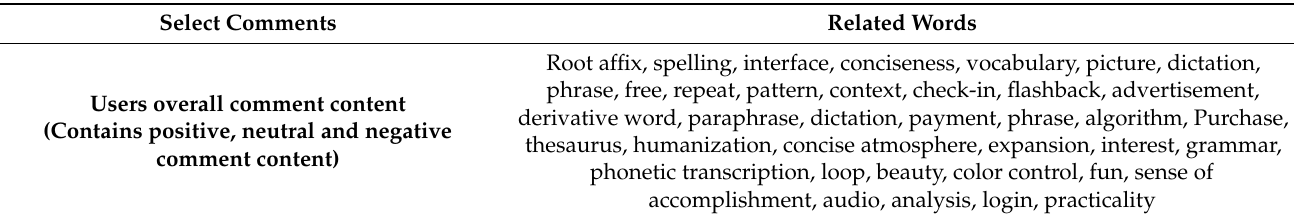
Table 5. BuBeiDanCi comments on content hot high-frequency keywords.